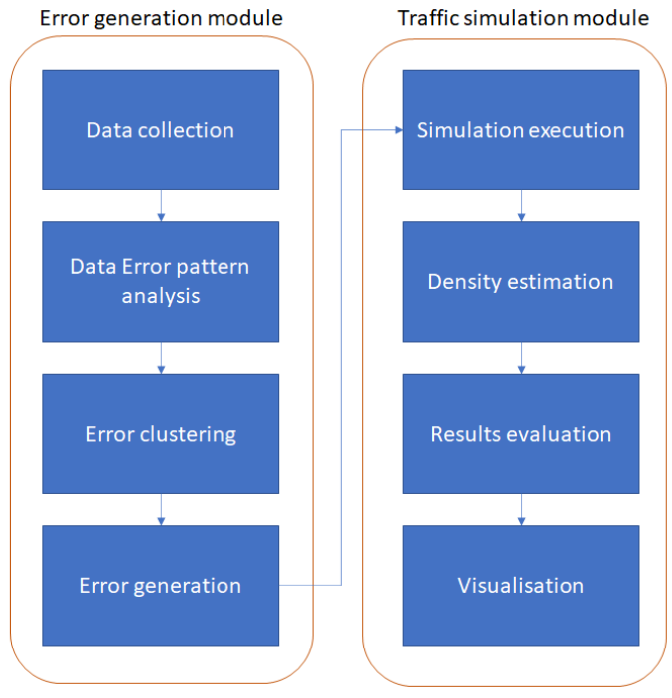
Figure 8. Traffic density estimation algorithm [40].